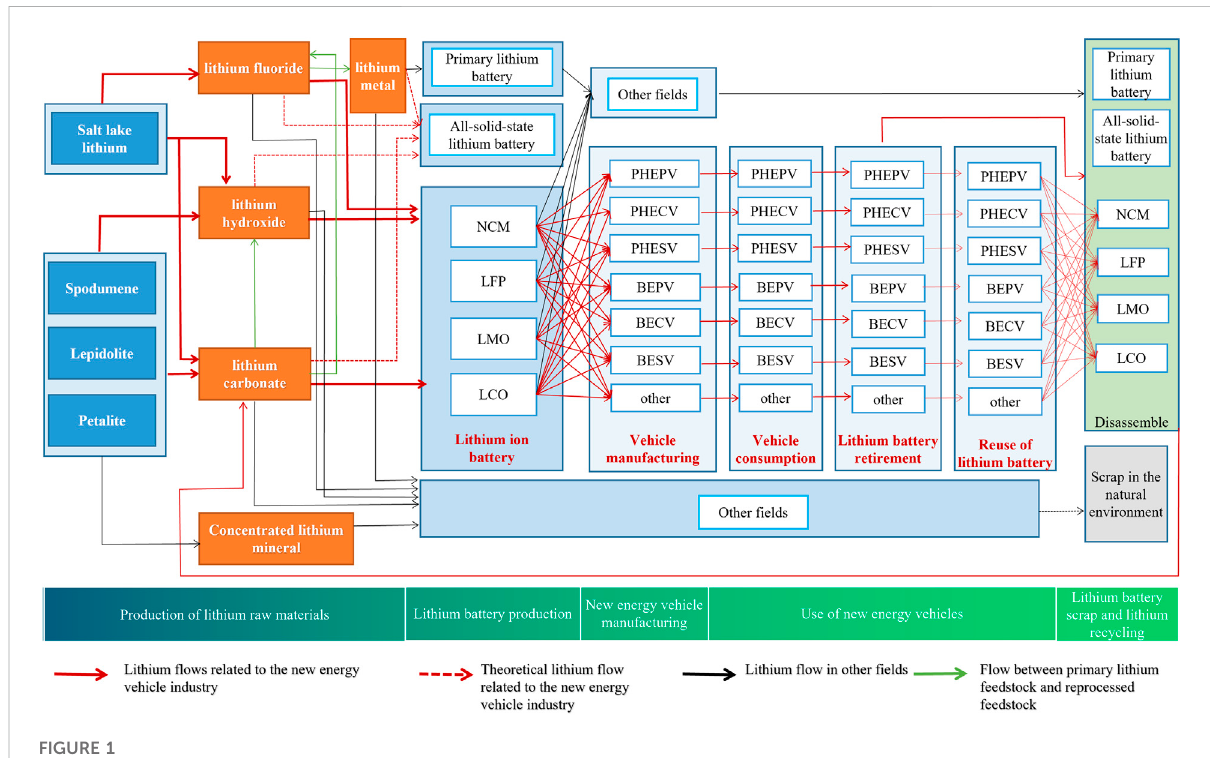
FIGURE 1 “ Lithium ” fl ow under the new energy vehicle industry